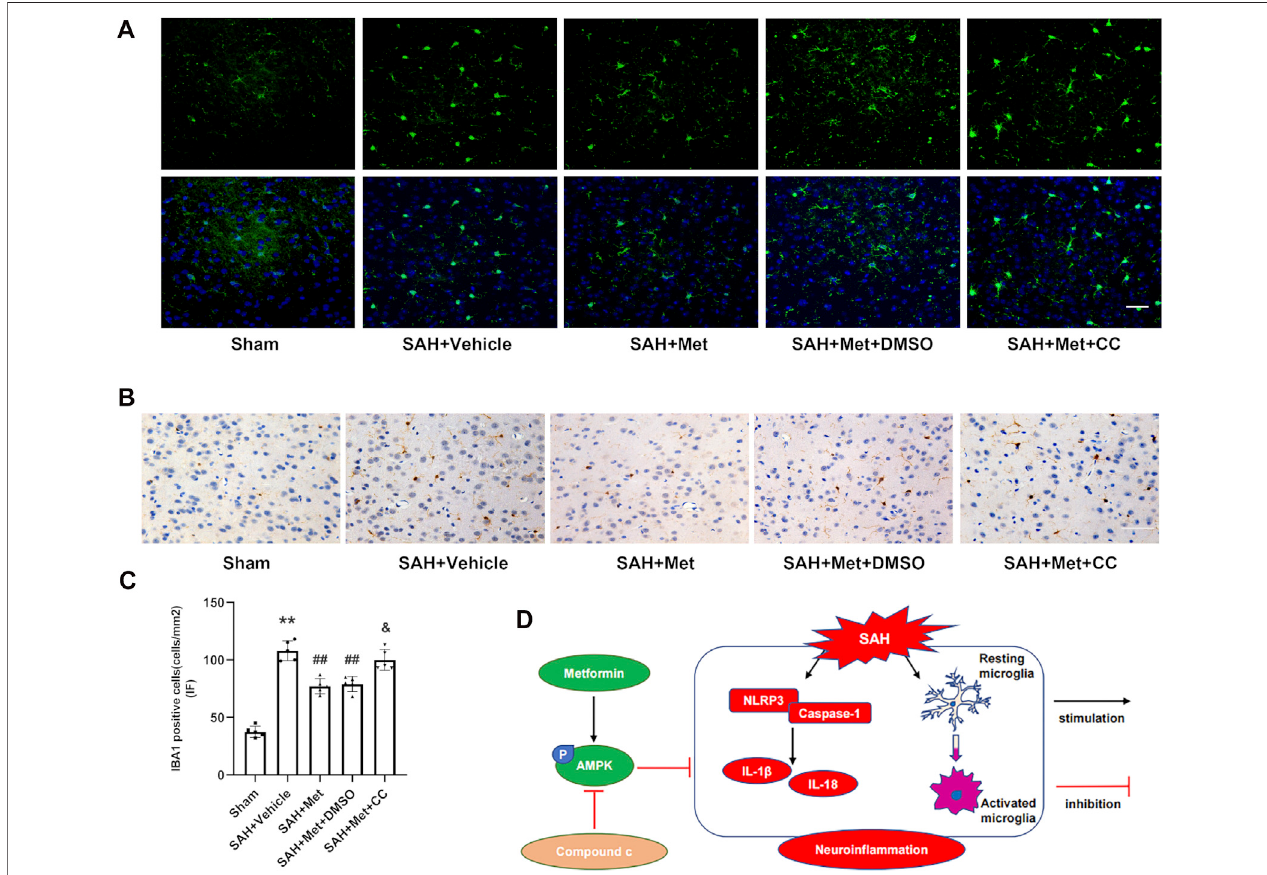
FIGURE 8 | Suppression of AMPK reverses the inhibitory effects of metformin on microglial activation after SAH. (A,C) Representative images of immuno fl uorescencestainingandquanti fi cationofIBA1activation. (B) RepresentativeimagesofimmunohistochemicalstainingofIBA1activation(Magni fi cation=×400, scale bar = 50 um, n = 5 per group). Data are shown as mean ± SD. ** p < 0.01 vs. sham group. ## p < 0.01 vs. SAH + Vehicle (normal saline) group. & p < 0.05 vs. SAH + Metformin + DMSO group. (D) Graphical abstract of how metformin regulates SAH-induced neuroin fl ammation via AMPK-dependent